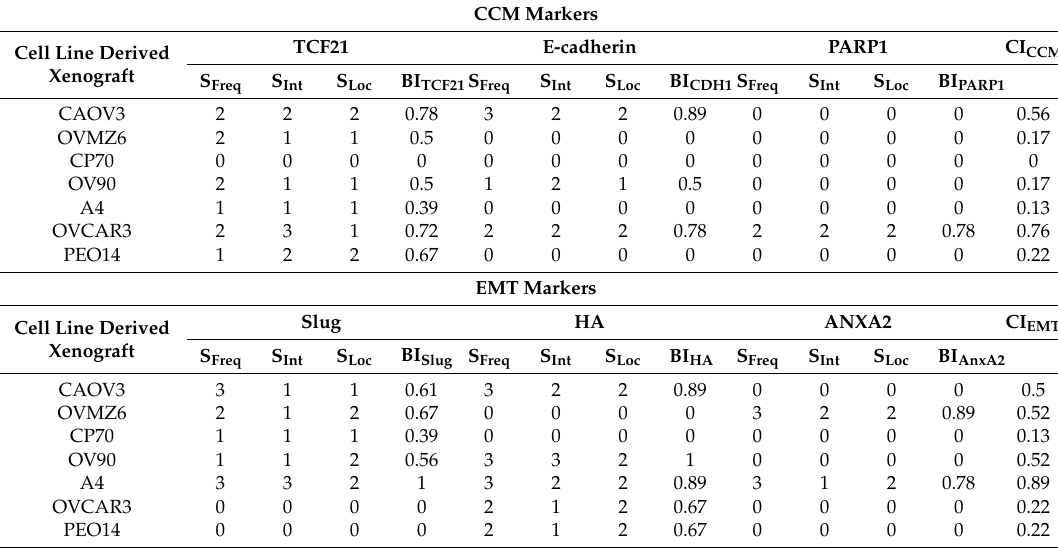
Table 1. Scores, biomarker and class indices (BI and CI respectively) for cooperative cell migration (CCM) and epithelial-to-mesenchymal transition (EMT) markers in xenografts. CCM Markers Cell Line Derived Xenograft